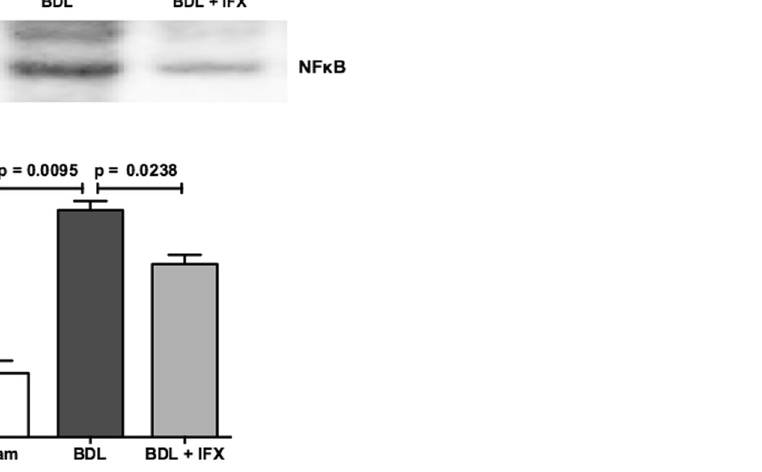
Figure 1. NFkB expression in rat liver. Western blotting shows that expression of the p65 subunit of NFkB is increased in BDL rat livers compared to sham, and is decreased by IFX treatment. (Sham n = 4; BDL n = 6; BDL + IFX n =